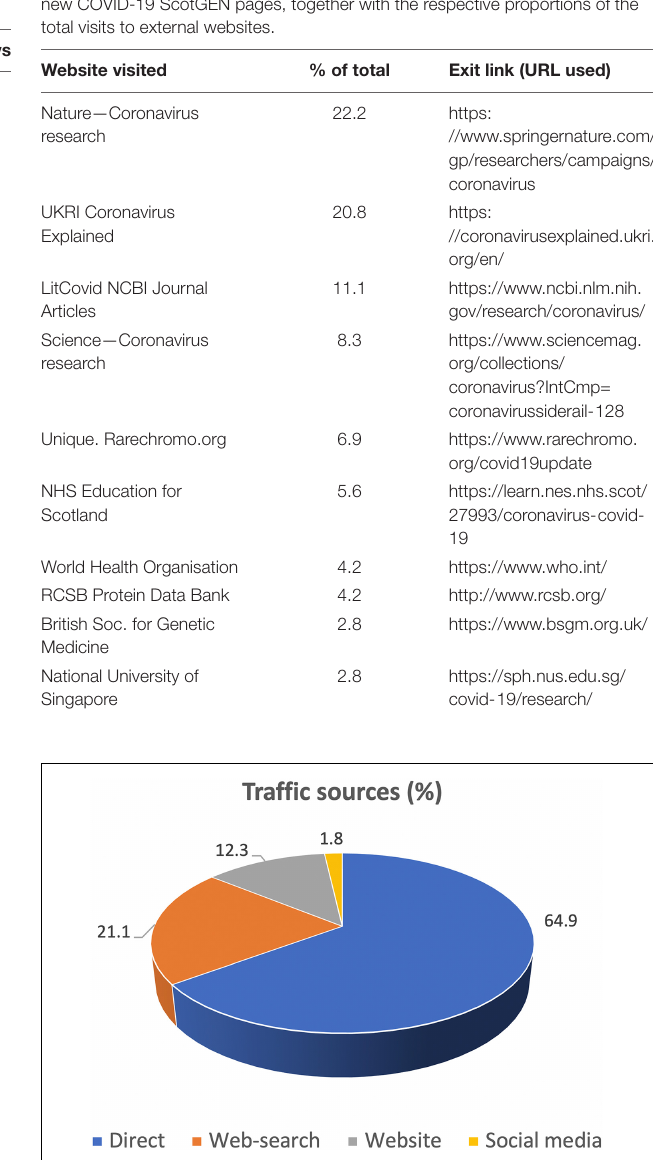
FIGURE 2 | Proportions of visits to ScotGEN’s COVID-19 web pages attributable to different website traffic